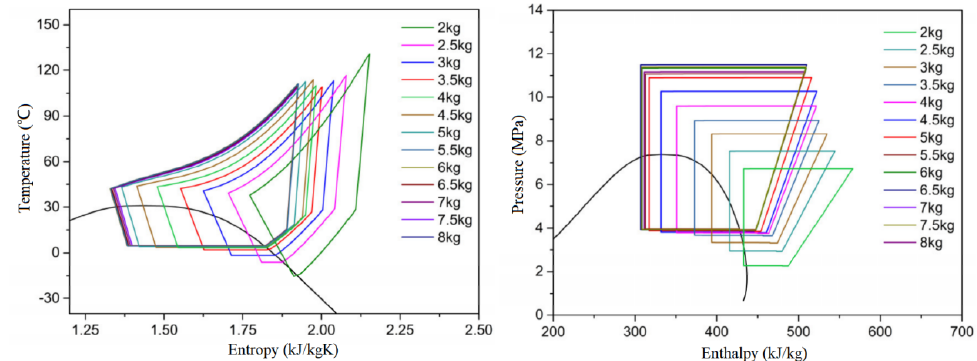
Figure 5. The T − s diagram and P − h diagram of the transcritical CO 2 cycle under various refrigerant charging amounts.